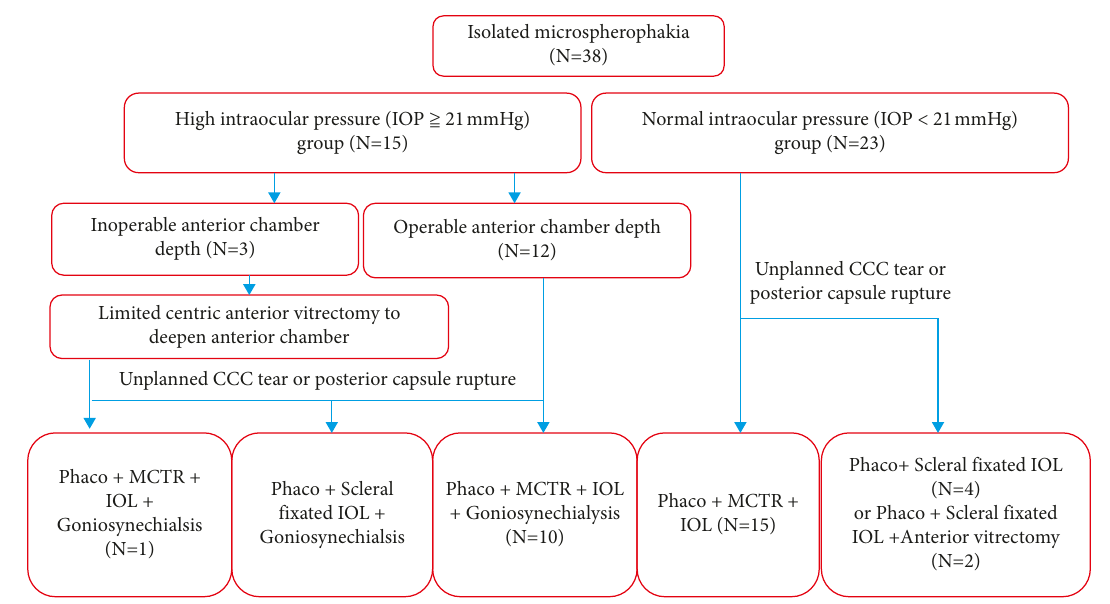
Figure 1: Subjects’ surgery flow chart. IOP: intraocular pressure; phaco: phacoemulsification; CCC: continuous curvilinear capsulorhexis; MCTR: modified capsular tension rings; IOL: intraocular lens. Table 1: Baseline characteristics of total